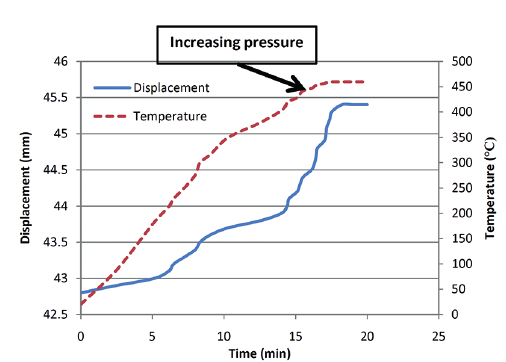
Figure 2: Displacement and temperature changes versus sintering time. reaches a maximum. The maximum displacement of 2.5 mm was measured in the present work. It is worth noting that the final stage of sintering process can be distinguished from the constant change of